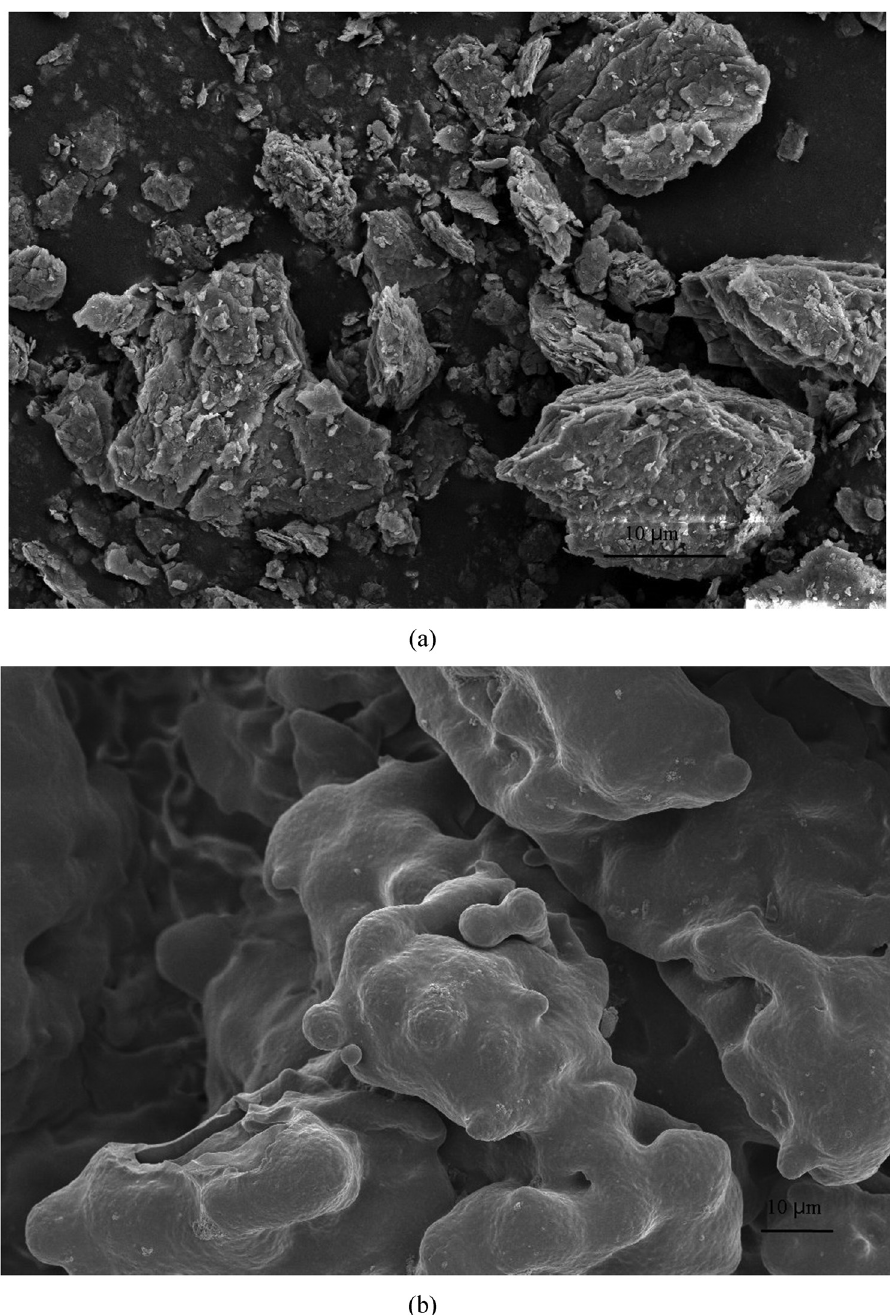
Figure A7: SEM micrographs of the surfaces of PPC ( a ) and PPCIAn ( b )